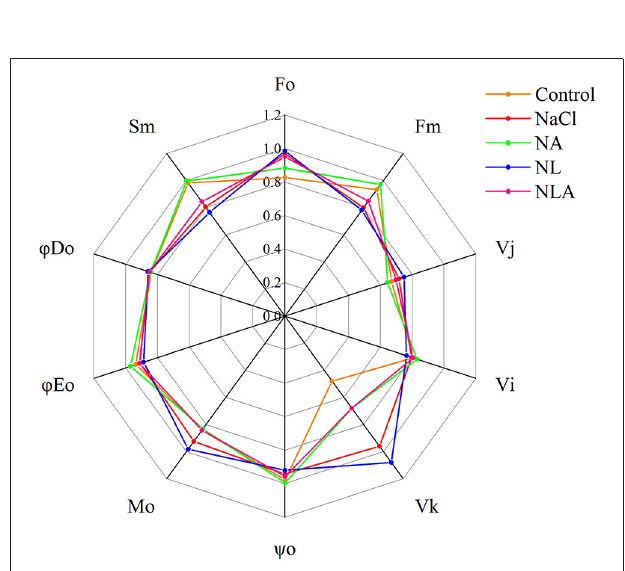
FIGURE 7 | Spider plots of the JIP parameters deduced from chlorophyll a fluorescence OJIP transient curves in leaves of salt-stressed tomato seedlings with or without exogenous ascorbic acid (AsA) and lycorine (LYC) spraying. Values are means ± SD ( n = 3). Control, no added NaCl, no sprayed AsA and LYC; NaCl, added 100 mmol/L NaCl; NA, added 100 mmol/L NaCl and sprayed 0.5 mmol/L AsA; NL, added 100 mmol/L NaCl and sprayed 0.25 mmol/L LYC; NLA, added 100 mmol/L NaCl and sprayed 0.25 mmol/L LYC and 0.5 mmol/L AsA.